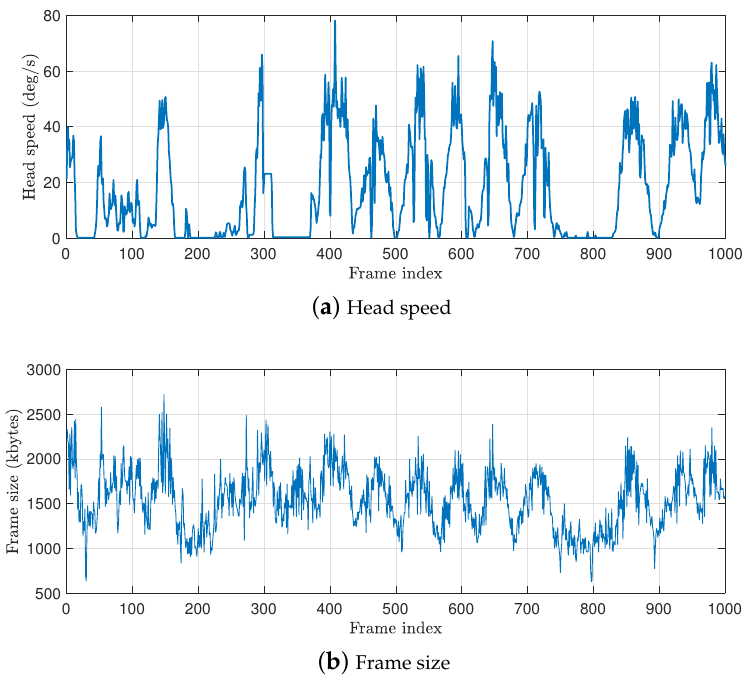
Figure 6. Changes in the head angular speed and encoded frame size with